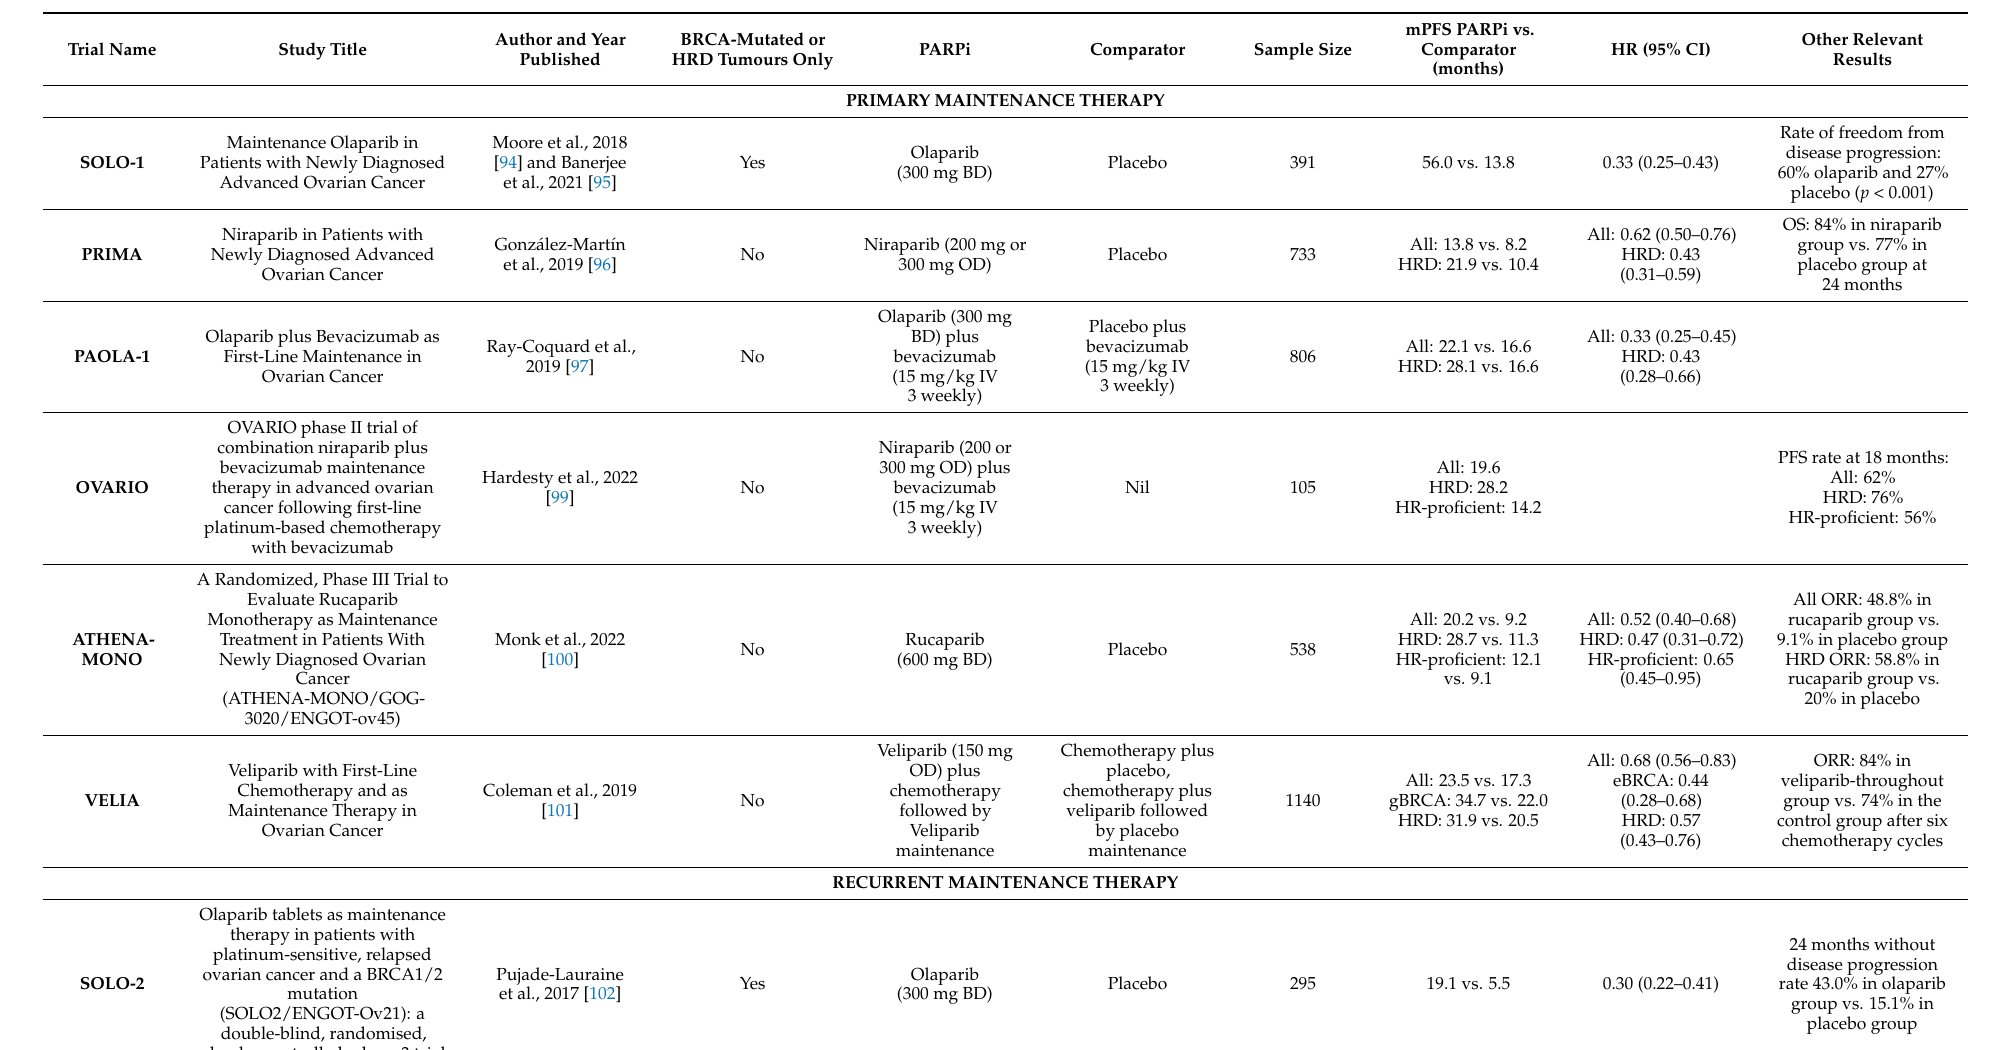
Table 1. Summary of pivotal trials of PARPis for advanced ovarian